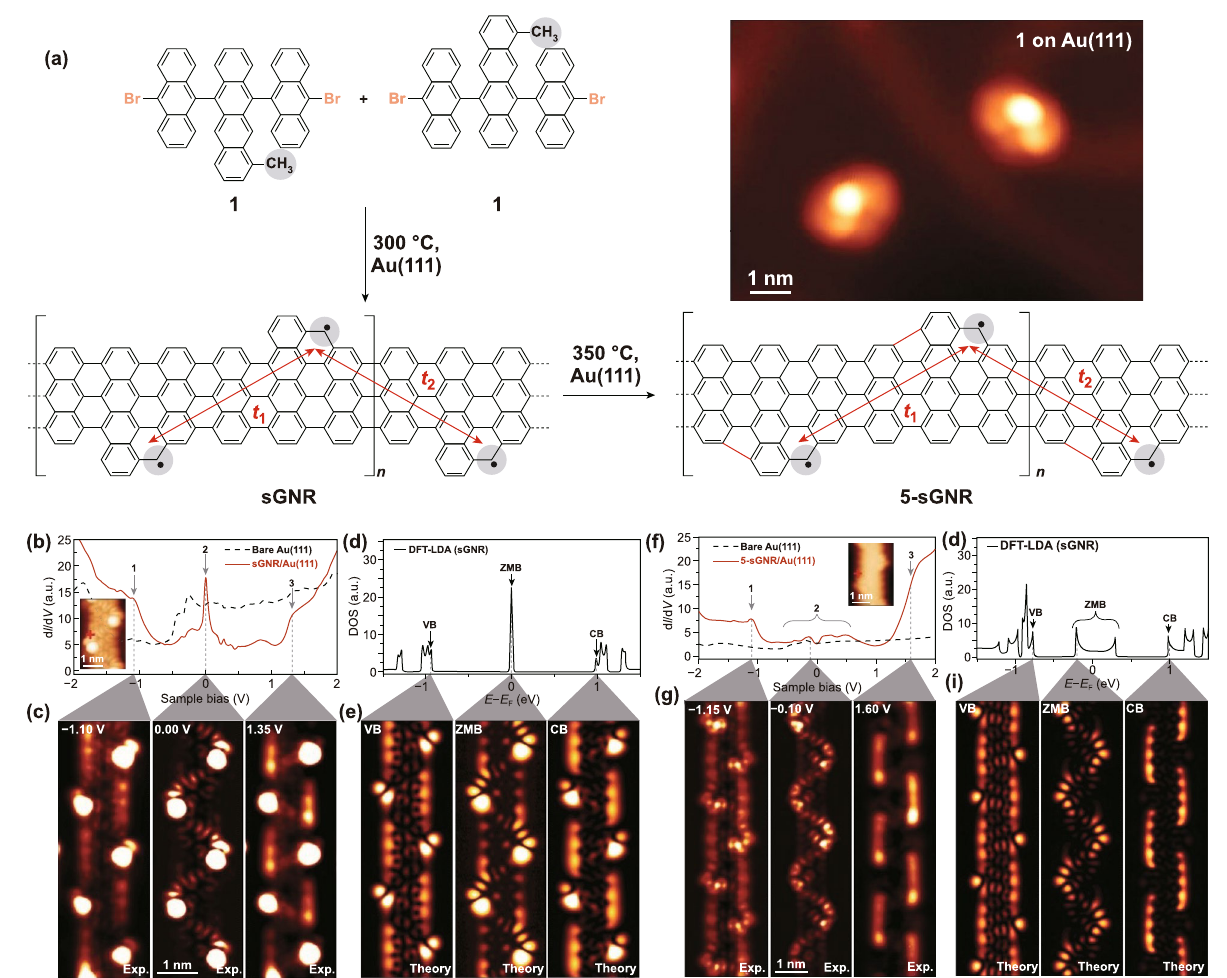
Fig. 1 a Schematic bottom‑up growth of sGNRs and 5‑sCNRs from molecular precursor 1 on Au (111), and the inset at the top right corner shows STM topograph of two isolated monomers of precursor 1. b-e Electronic structure of sGNRs. b experimental d I /d V point spectroscopy, c related constant‑height d I /d V maps in real space, d DFT‑LDA calculated DOS, and e related local DOS maps of a sGNR. f-i Electronic structure of 5‑sCNRs. f experimental d I /d V point spectroscopy, g related constant‑height d I /d V maps, h DFT‑LDA calculated DOS, and i related local DOS maps of a 5‑sCNR. Reproduced from Ref. [9]. Copyright 2020 American Association for the Advancement of